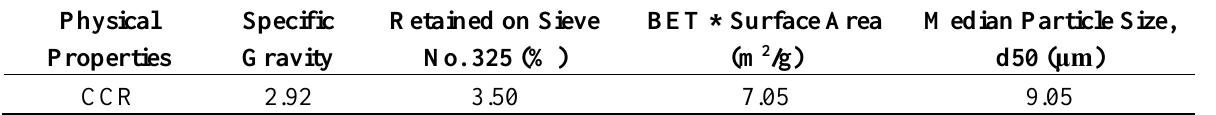
Table 2. Physical properties of CCR.